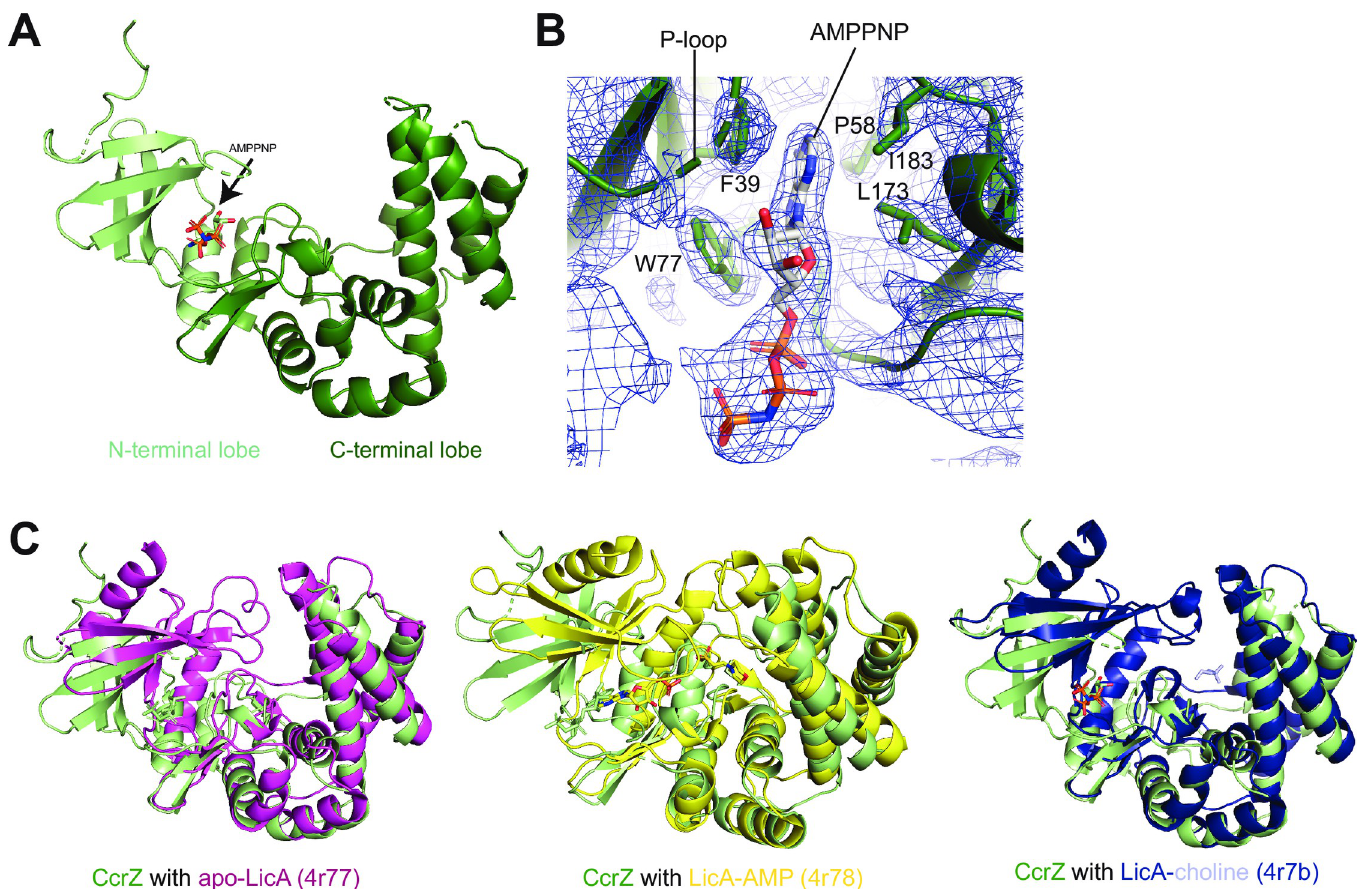
Fig 3. Structural determination of CcrZ and comparison to S . pneumoniae LicA. (A) Structure of CcrZ bound to AMP-PNP. N-terminal lobe in light green, C-terminal lobe in dark green. (B) 2F o -F c map contoured at 1 σ around the AMP-PNP molecule in the kinase pocket (P-loop highlighted) of the CcrZ crystal structure with aromatic and hydrophobic residues flanking the base shown as sticks. While the base occupies its pocket in the enzyme, the rest of the AMP-PNP is swung out of the active site and is directed towards the solvent. (C) CcrZ-AMP-PNP aligned with apo-LicA 4r77 (left), CcrZ-AMP-PNP aligned with LicA-AMP 4r78 (middle), CcrZ-AMP-PNP aligned with LicA-choline 4r7b (right). In all three alignments, the cleft between the N- and C-terminal lobes is wider in the CcrZ structure than in the LicA